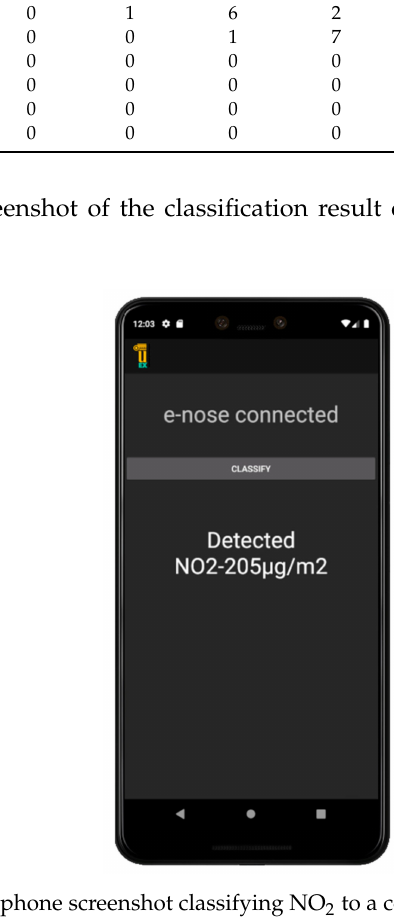
Figure 8. Smartphone screenshot classifying NO 2 to a concentration of 205 µ g / m 3